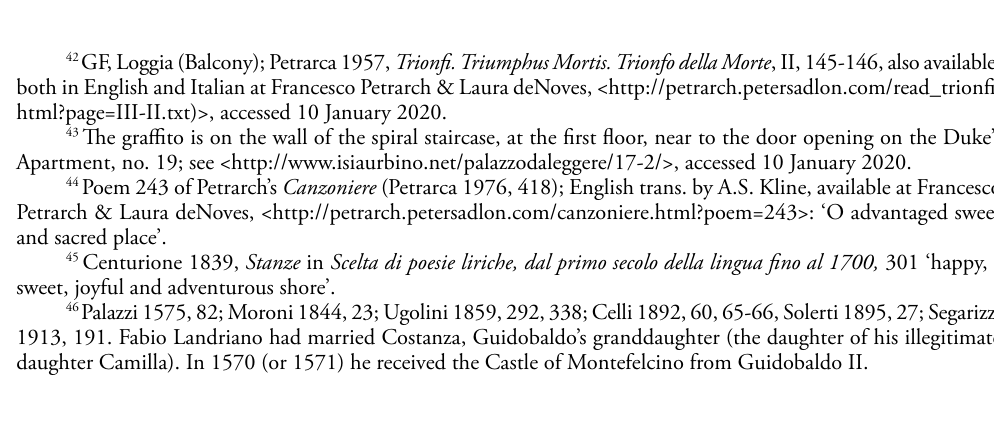
Figure 8 – Graffito ‘Felice dolc aventuroso loco Fabio Lan. no ’. Photo by Manuele